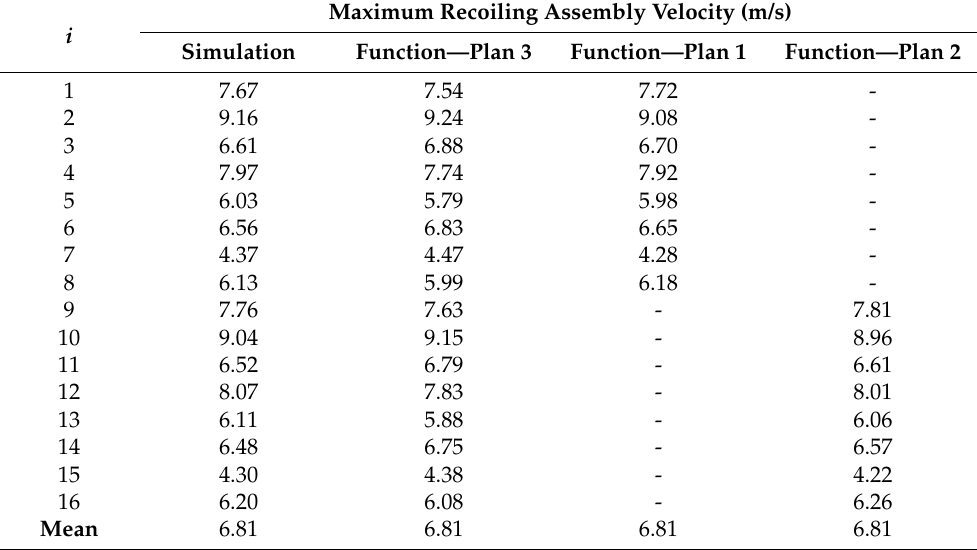
Table 8. The results of simulation (for plan 3) compared with the results approximated by the obtained function (for plan 1, 2 and